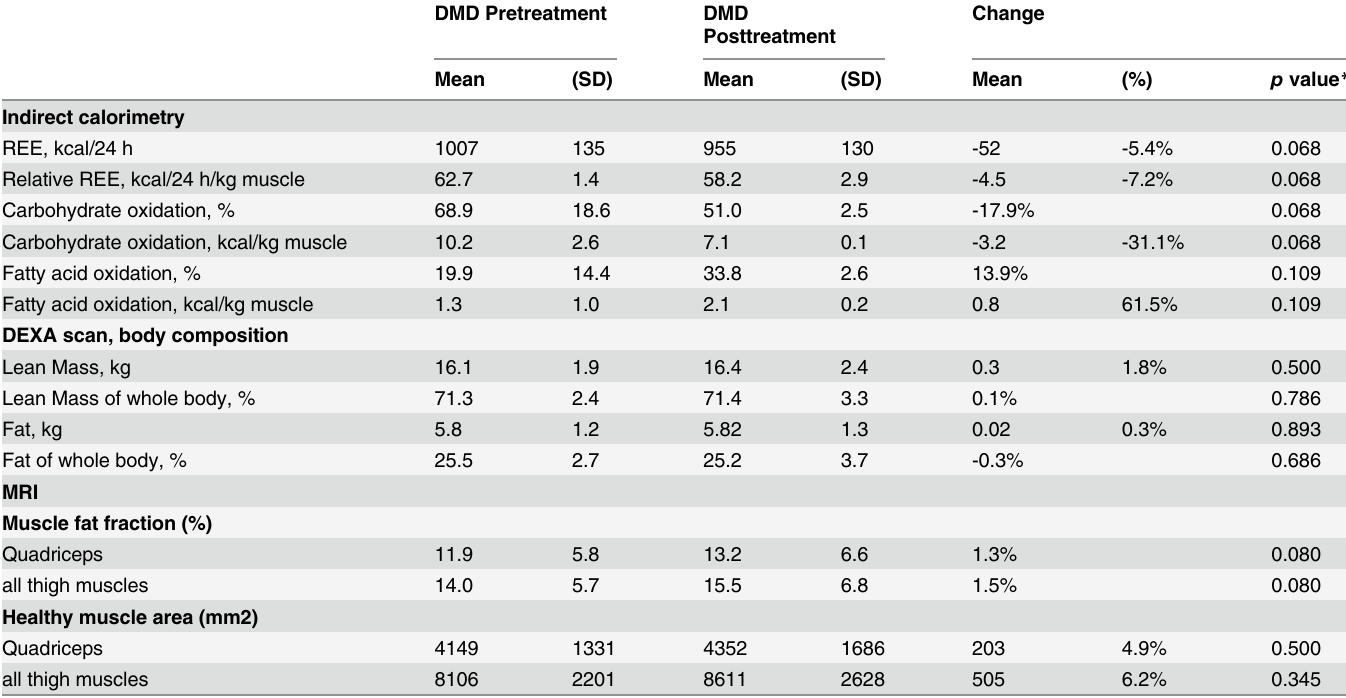
Table 3. Summary of indirect calorimetry, DEXA, and muscle MRI